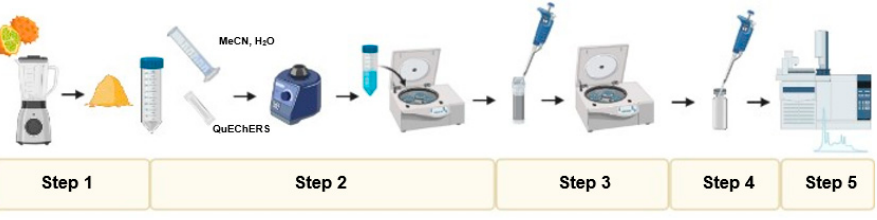
Figure 1. Scheme of the experimental procedure.